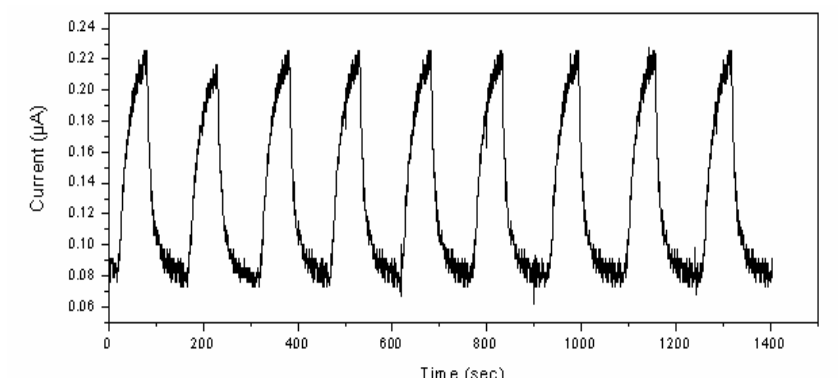
Figure 12. Cyclic behaviour of 50 ppm hydrogen and pure nitrogen gas exposure to the sensor element Pt | Nafion ® with an electrode area of 2 cm 2 prepared from 0.01 M Pt(NH (sample K1) at one minute time